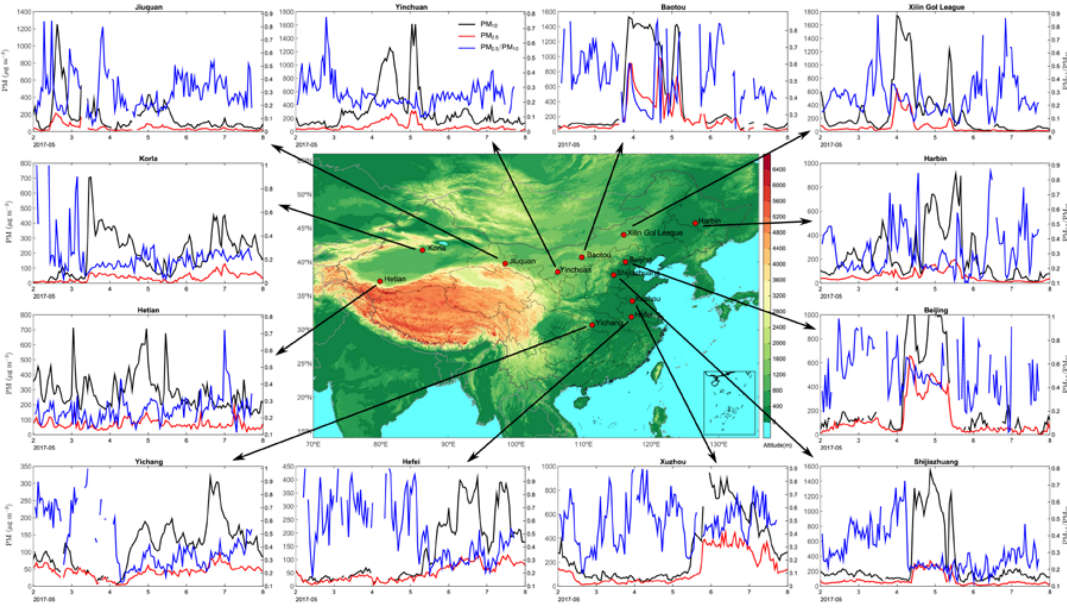
Figure 3. Hourly average spatial distribution of PM 2.5 , PM 10 , and PM 2.5 /PM 10 at 12 typical stations